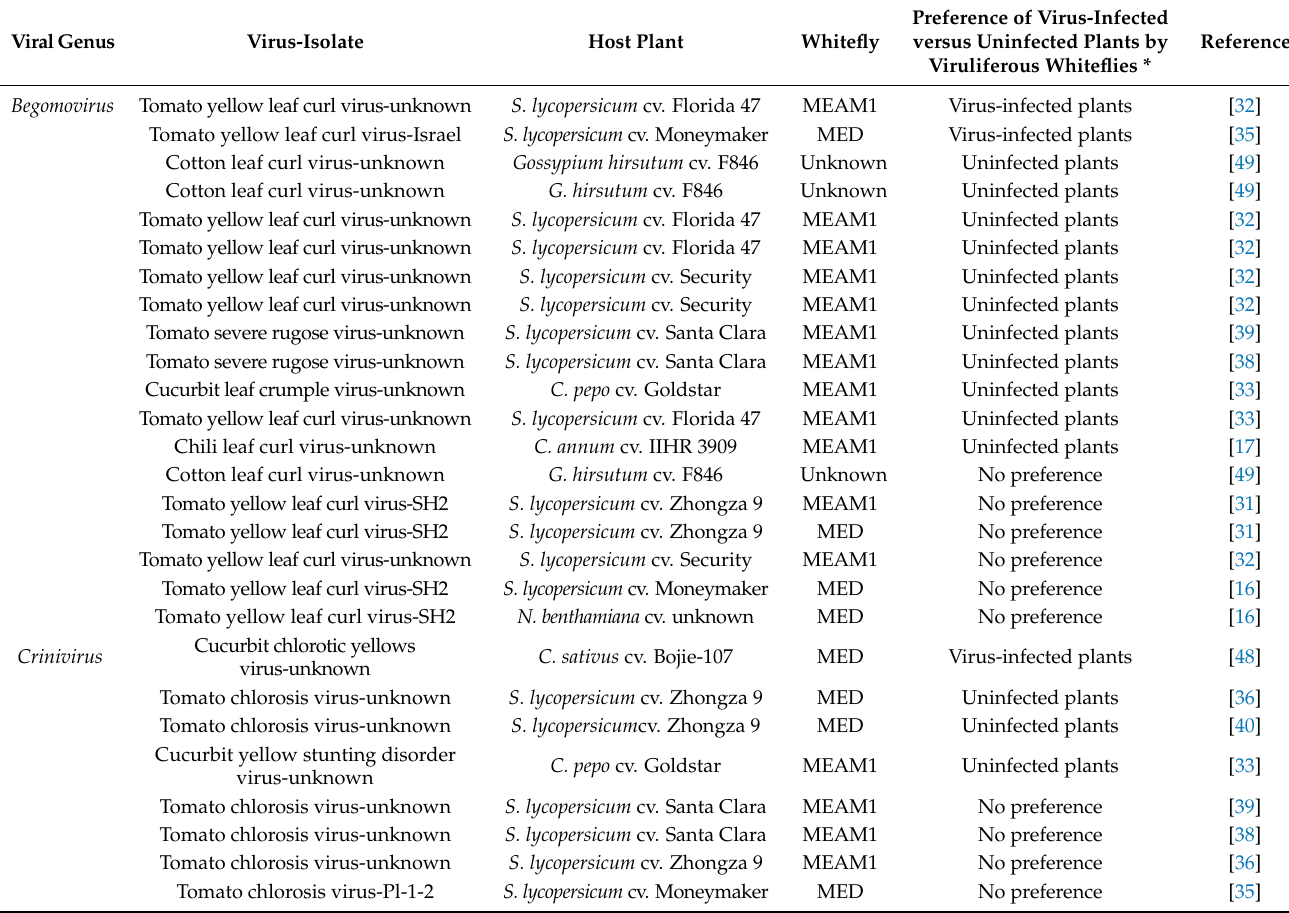
Table 2. Direct effects of virus infection on whitefly